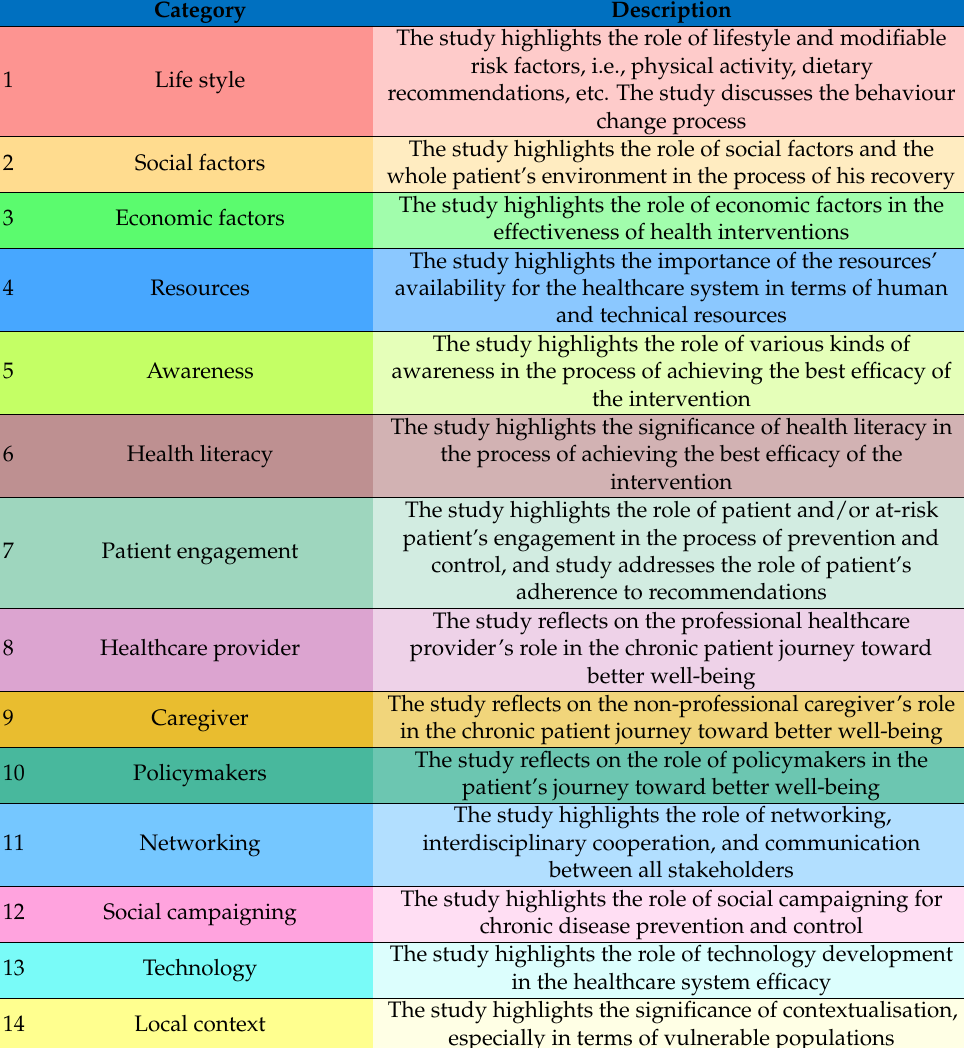
Table 1. Category of the priority focus in the selected